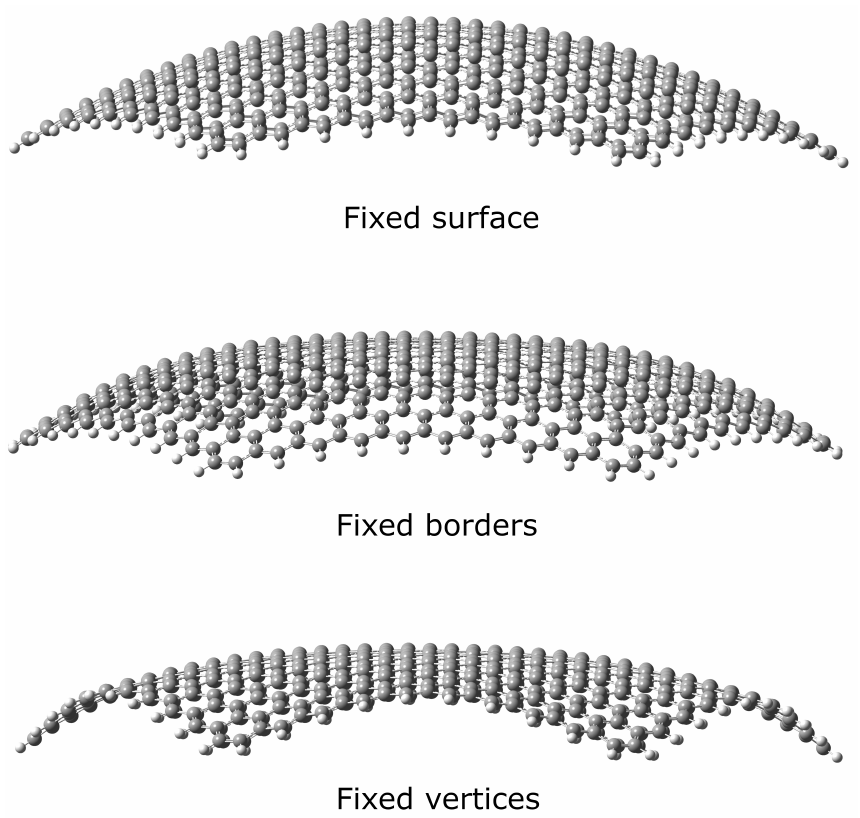
Figure 2. Optimized geometries for a (quasi-)spherical graphene flake of radius 40 Å (image generated using GausView 6